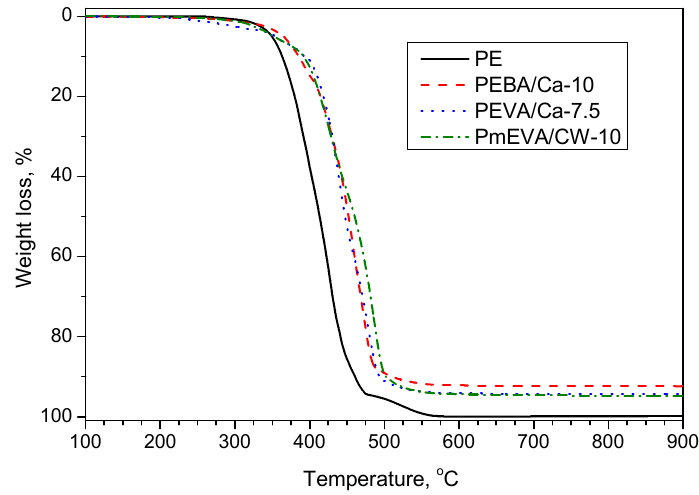
Figure 8. Thermogravimetric curves for selected MMT-based PE composites.